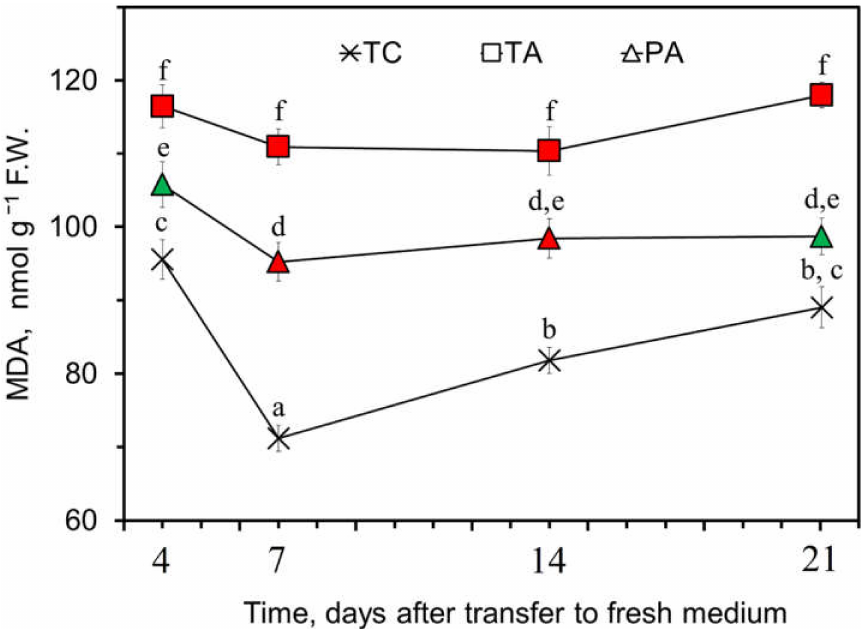
Figure 2. Effect of antibiotic treatment on MDA accumulation in tobacco in vitro shoots. Control (TC) ( × ), 250 mg L − 1 timentin-treated (TA) ( (cid:3) ) and post-antibiotic treatment (PA) ( ∆ ) experimental groups were maintained as described in the Methods. Data from four independent experiments are presented as the mean ± standard error (Appendix A Table A1). The color of the symbols represents significant differences of the mean values compared to the control at each time point (green— p < 0.05, red— p < 0.01). Different letters denote significant differences among the time points ( p <